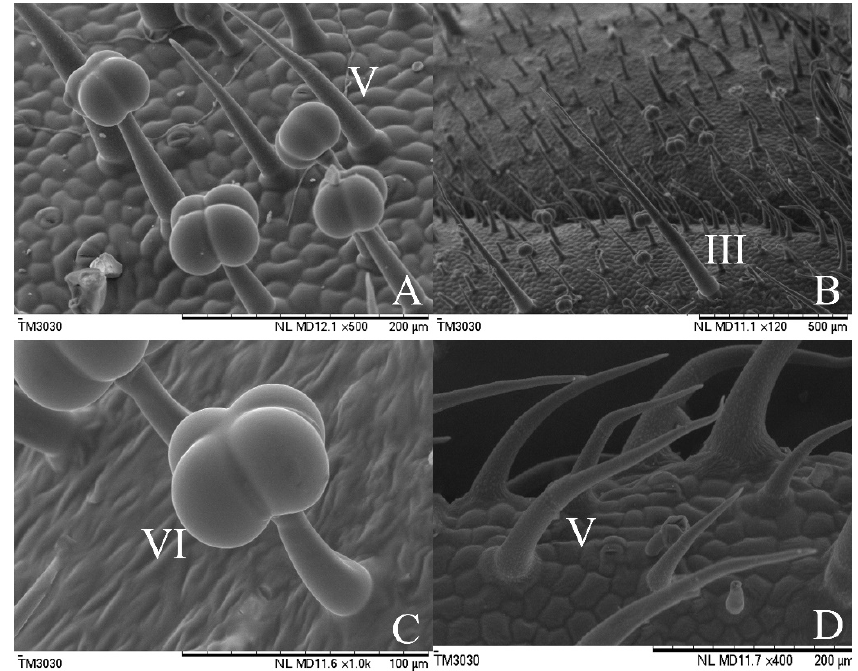
Figure 4. Morphological observation of di ff erent types of trichomes of tomato JR (tomato cultivar Jia Ren) under a scanning electron microscope. The gross state of the JR cultivar was observed by scanning electron microscopy, and di ff erent types of trichomes are marked in the picture. Scale bars ( A ) = 200 µ m, ( B ) = 500 µ m, ( C ) = 100 µ m, ( D ) = 200 µ